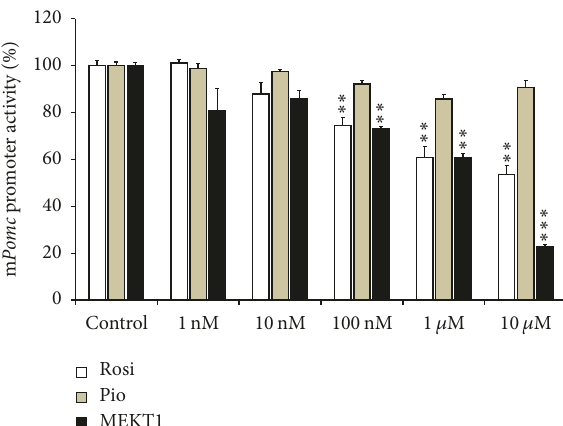
∗∗∗∗∗∗∗∗∗∗∗∗∗ Figure 2: Effects of MEKT1, rosiglitazone, and pioglitazone on Pomc promoter activity in AtT20 cells. AtT20 cells transiently transfected with 300 ng full length r Pomc -Luc ( − 703/+58-luc) and 100ng pRSV- 𝛽 -gal were treated with MEKT1, rosiglitazone (Rosi), and pioglitazone (Pio) (1nM, 10nM, 100 nM, 1 𝜇 M, or 10 𝜇 M) or 0.1% DMSO (vehicle control) for 24 hours. Data are expressed as percentages (100%) of control. Each point represents mean ± SEM ( 𝑛 = 4 ). ∗∗ 𝑃 < 0.01 , ∗∗∗ 𝑃 < 0.001 versus control.